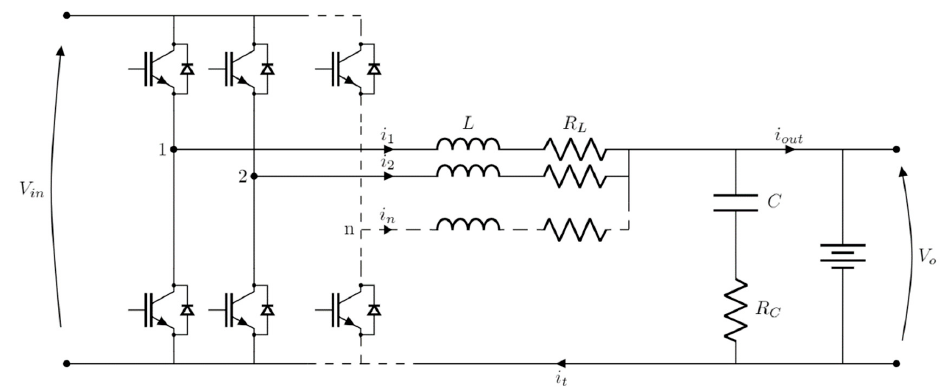
Figure 1. Interleaved buck converter.